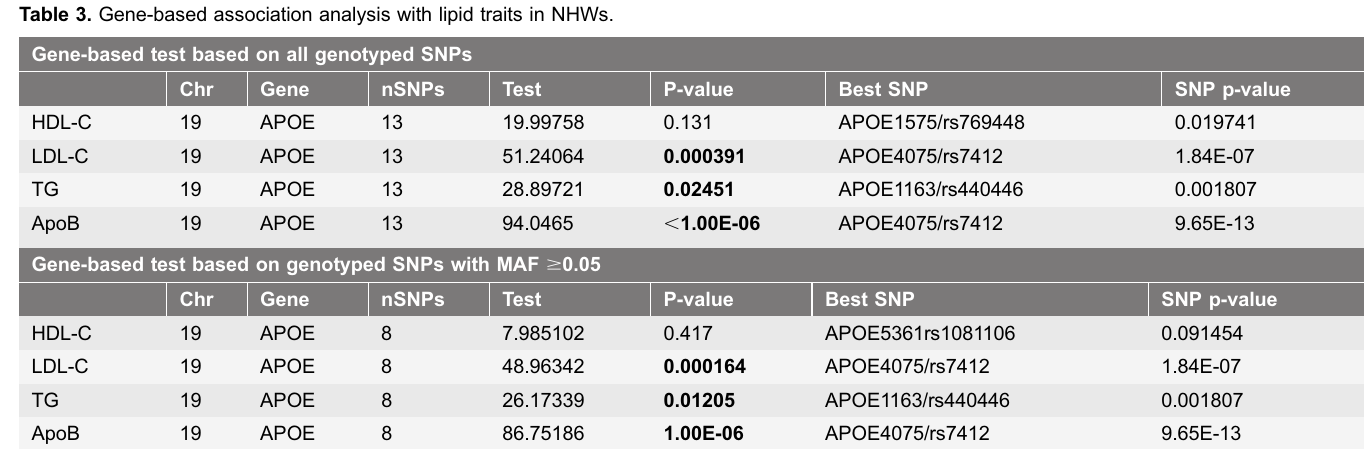
Table 3. Gene-based association analysis with lipid traits in